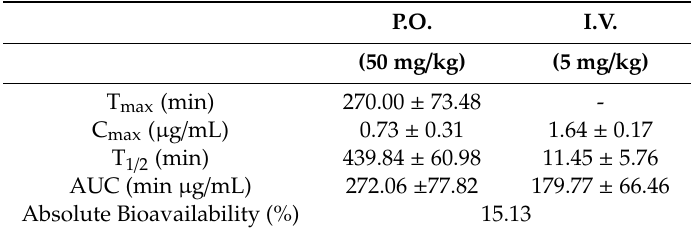
Figure 3. Plasma concentration–time curves of Erinacine S in rats after ( A ) oral administration of H. erinaceus mycelia extract at 2.395 g/kg body weight (equivalent to 50 mg/kg body weight of Erinacine S) and ( B ) intravenous administration of Erinacine S at 5 mg/kg. Values are means ± SD ( n = 6). Table 3. Pharmacokinetic parameters of Erinacine S in rat plasma after oral administration of H. erinaceus mycelia extract at 2.395 g / kg body weight (equivalent to 50 mg / kg body weight of Erinacine S) and intravenous administration of Erinacine S at 5 mg/kg.